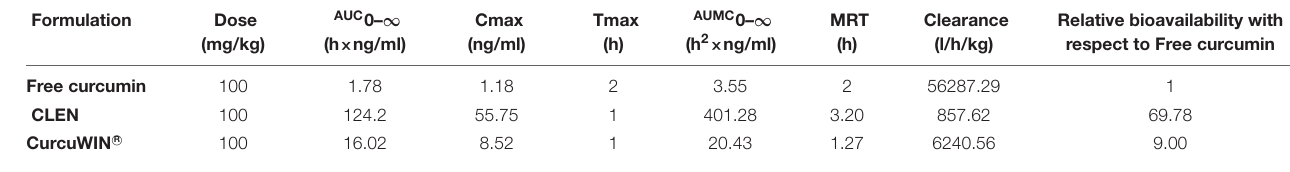
TABLE 5 | Various pharmacokinetic parameters obtained after a single oral dose of free curcumin, CurcuWIN R (cid:13) and CLEN administered to rats ( n = 3).